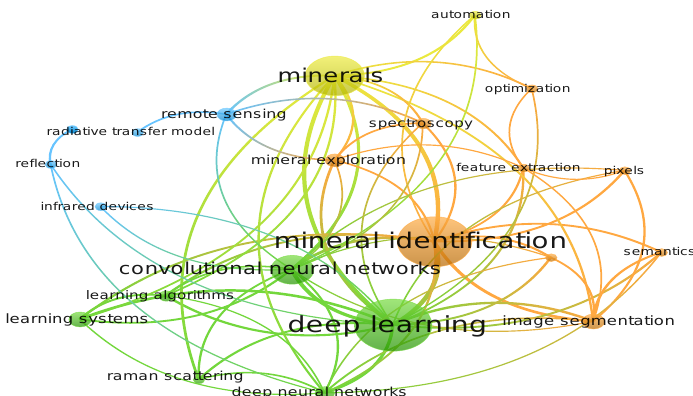
Figure 7. Keyword detection of deep-learning-based